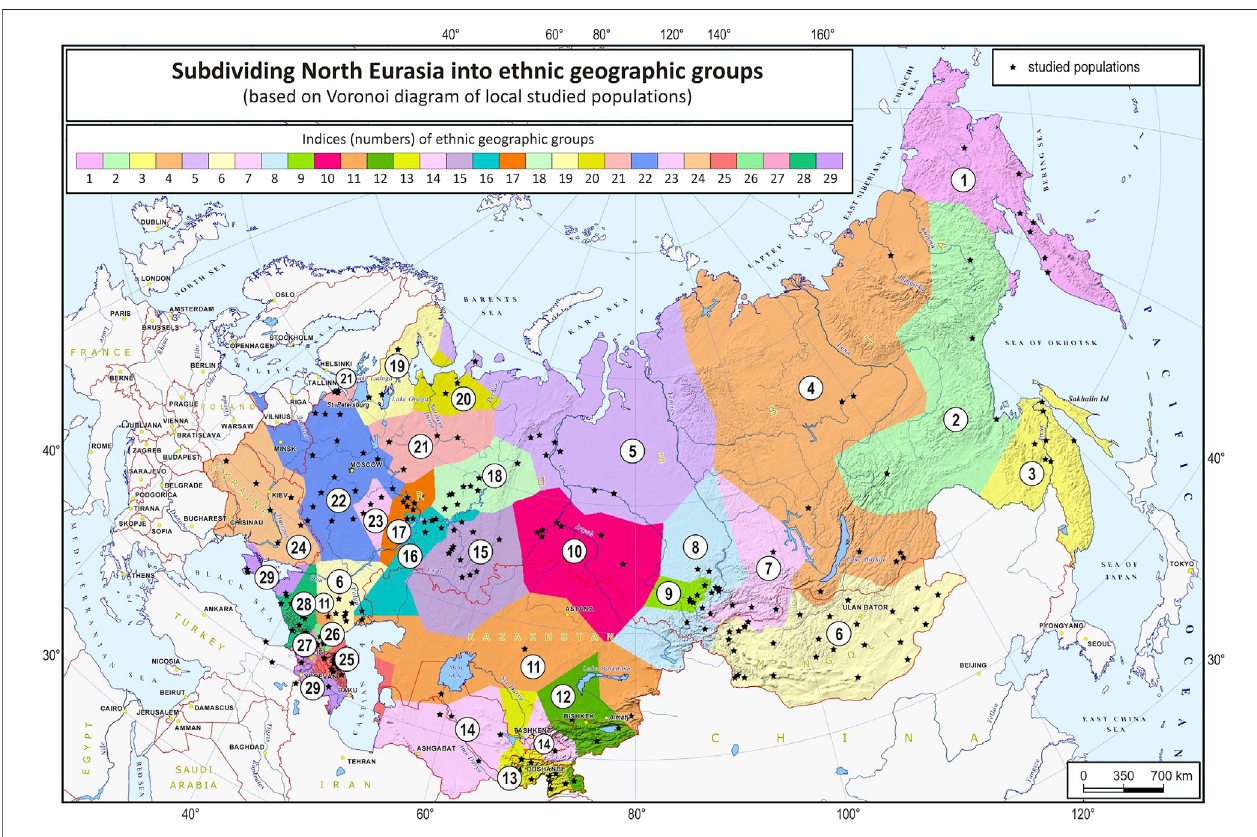
FIGURE 2 | North Eurasia divided into genetically distinguishable ethnic geographic groups. Notes. Colored zones on the map designate areas occupied by the identi fi ed ethnic geographic groups. Groups are numbered according to their geographic coordinates. Black stars represent local populations (coincide with the populations in Figure 1